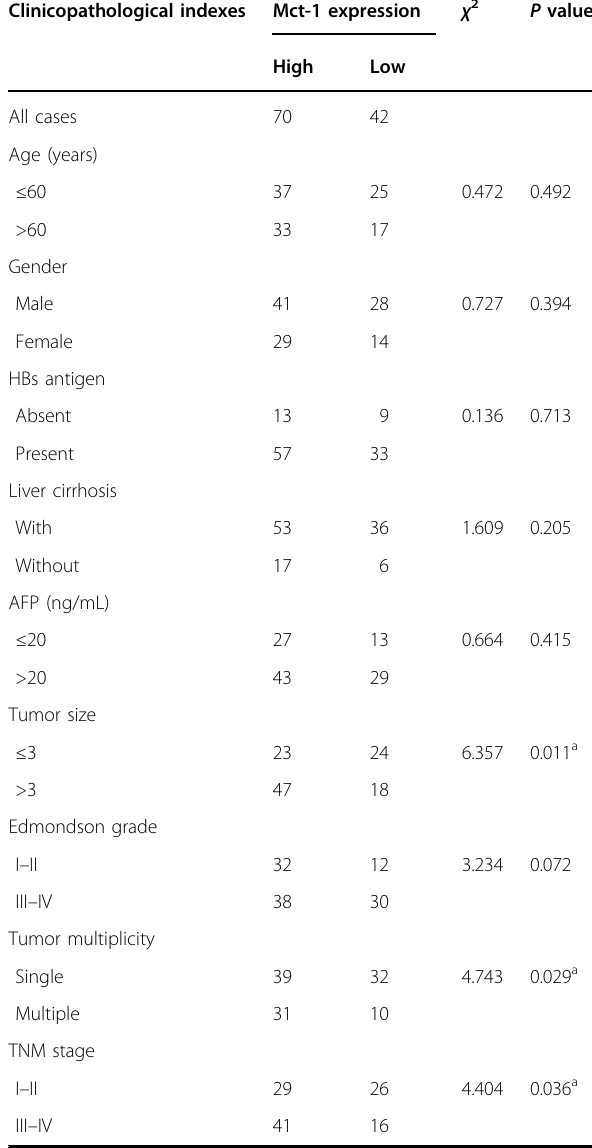
Table 1 Association between Mct-1 expression and clinicopathologic features of patients with HCC ( n = 112). Clinicopathological